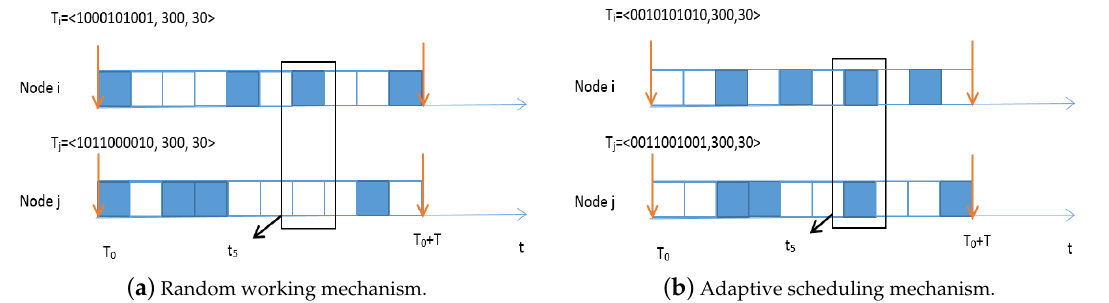
Figure 2. Contact comparison between random working mechanism ( a ) and adaptive scheduling mechanism ( b